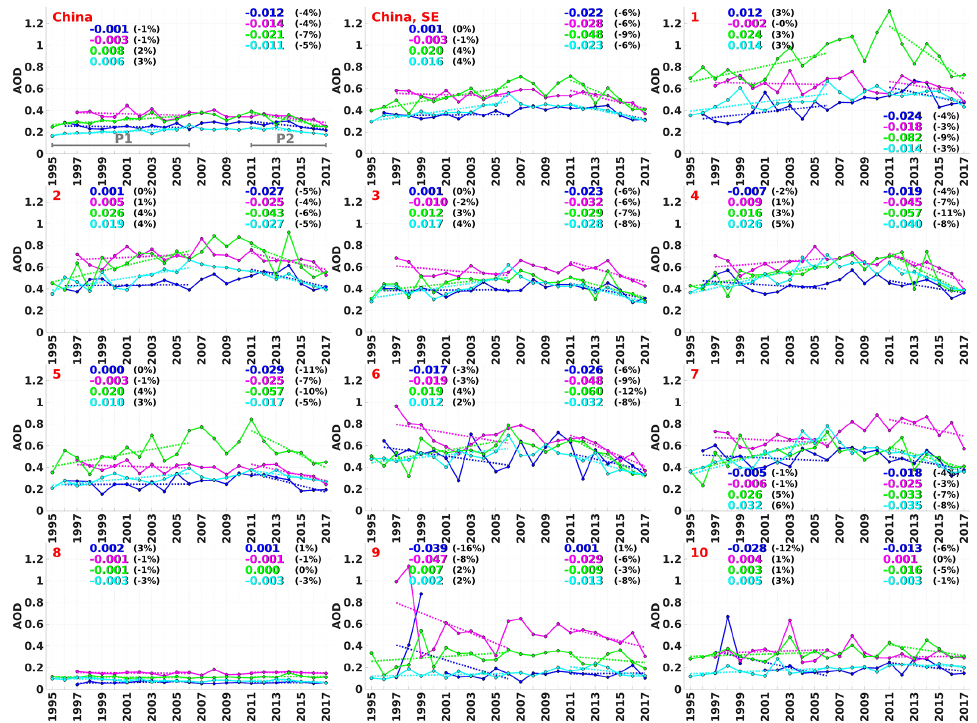
Figure 10. The AOD seasonal long-time series (solid lines), the linear fits (dashed lines) and the AOD tendency (numbers) for P1 (1995– 2011) and P2 (2011–2017; shown using grey lines in the upper left subplot) are shown using different colors for each season (DJF – blue, winter; MAM – purple, spring; JJA – green, summer; and SON – cyan, autumn). The corresponding relative AOD tendencies for each fit are shown in brackets (in black;